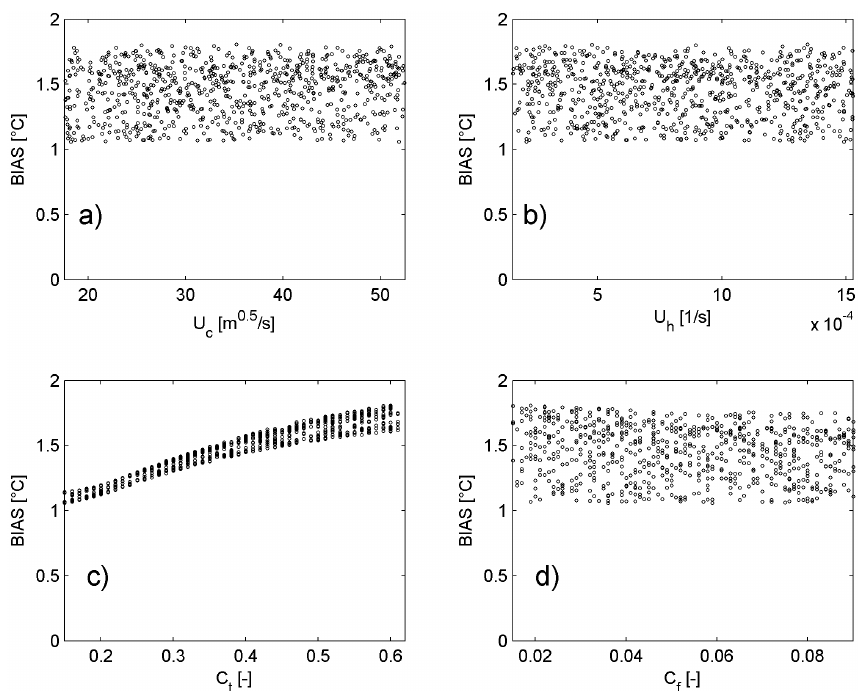
Figure 9. The Orba basin, August–September 2009. Dotty-plot representation of the BIAS on mean LST at basin scale. Each subplot reports the parameter value on x axis and the value of BIAS statistic on y axis. The parameter c t (c) has a quite clear range where BIAS reaches minimum values independently from the other parameters. This does not occur for the other parameters (a, b, d) . Table 6. The Orba basin skill scores on hydrographs for the entire validation period (2006–2011) and for the different parameter sets. The scores value is calculated for the two sections with available streamflow observations. PFRE is calculated with Q th = 200m 3 s − 1 for Casalcermelli section and with Q th = 50m 3 s − 1 for Tiglieto section. Basin Section Parameter N. S. CM